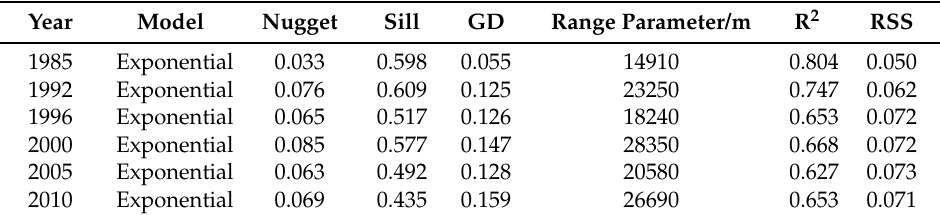
Table 3. Parameters of the exponential model for groundwater